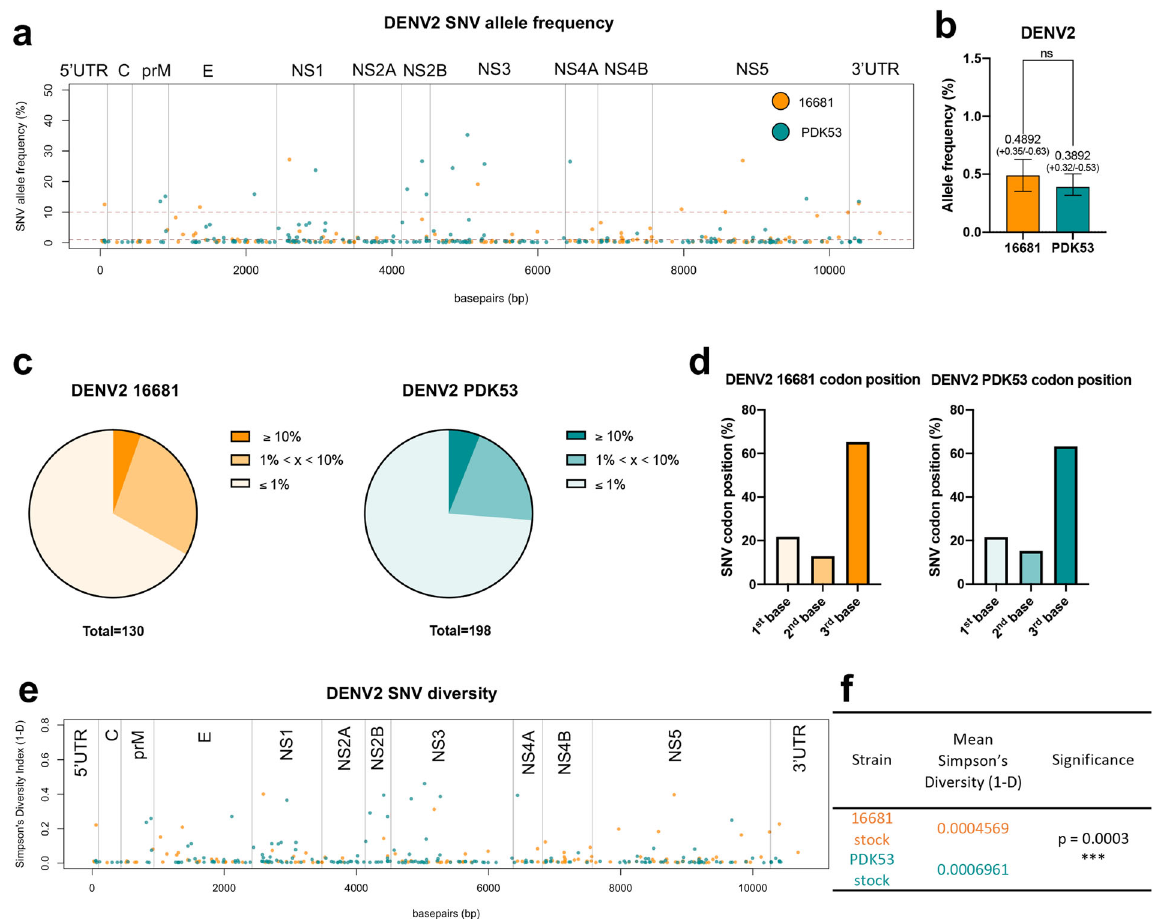
Fig. 1 DENV2 attenuated strain PDK53 is more genetically diverse than its parent wild-type strain 16681. a The allele frequency of SNVs identi fi ed in DENV2 wild-type 16681 (orange, n = 130) and its attenuated derivative PDK53 (teal, n = 198), are plotted along the genome. Horizontal dashed lines indicate an allele frequency of 1% (bottom) and 10% (top). b The mean allele frequency of SNVs identi fi ed in DENV2 16681 and PDK53 with their respective 95% con fi dence intervals. Signi fi cance was assessed by Mann – Whitney U test. c The percentage of SNVs with an allele frequency of ≤ 1, 1 < x < 10, or ≥ 10% in DENV2 16681 and PDK53. d The percentage of SNVs that locate to the 1st, 2nd, or 3rd codon position in both DENV2 16681 and PDK53. e The diversity of SNVs at each position in DENV2 16681 (orange) and PDK53 (teal) as measured by Simpson ’ s diversity index. f The mean diversity of each SNV in DENV2 16681 (orange) and PDK53 (teal). Signi fi cance was assessed by Mann – Whitney U